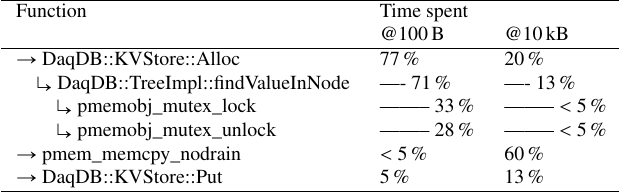
Table 1. Code profiling summary for 100B and 10kB fragment sizes for a minidaq readout thread with embedded